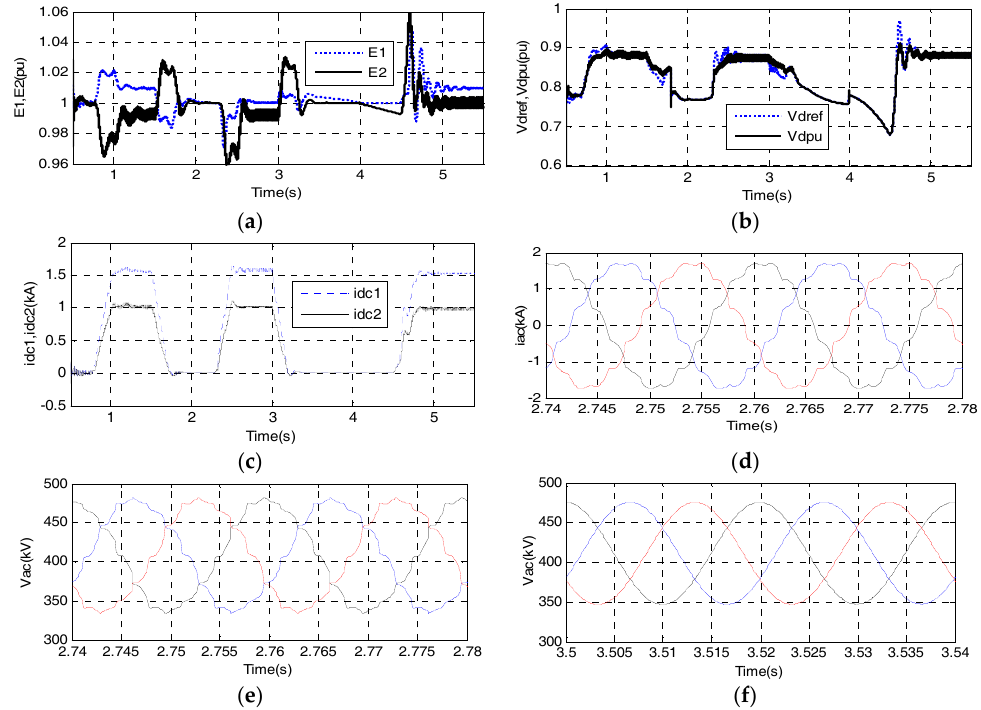
Figure 8. Simulation of operation of DUDAT under different control modes. ( a ) DC voltages at lower voltage side and higher voltage side of DUDAT; ( b ) V dref and V dpu ; ( c ) DC currents of DUDAT; ( d ) Output AC current of MMC1 under full DC power; ( e ) Output phase ground voltage of MMC1 under full DC power; ( f ) Output phase ground voltage of MMC1 under zero DC power.